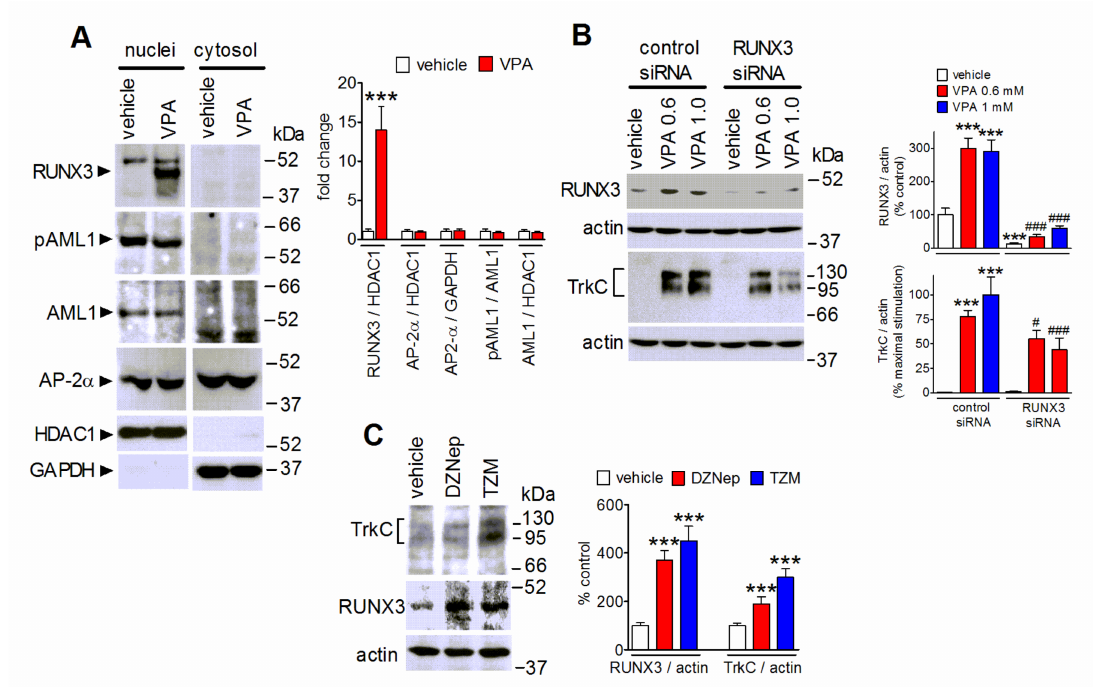
Figure 4. Involvement of RUNX3 in VPA-induced upregulation of TrkC. ( A ) SH-SY5Y cells were treated for 24 h with either vehicle or 1 mM VPA. Nuclear extracts and cytosolic fractions were prepared and analyzed for RUNX3, phospho-Ser249- AML1 (pAML1), AML1, AP-2 α , HDAC1 and GAPDH levels. Values are the mean ± SD of four independent experiments. *** p < 0.001 vs. control (vehicle) by Student’s t test. ( B ) SH-SY5Y cells transfected with either control siRNA or RUNX3 siRNA duplexes were incubated for 24 h with either vehicle, 0.6 mM VPA (VPA 0.6), or 1 mM VPA (VPA 1.0). Cell lysates were analyzed for RUNX3 and TrkC expression. Values are the mean ± SEM of four independent experiments. *** p < 0.001 vs. control (control siRNA + vehicle). # p < 0.05, ### p < 0.001 vs the corresponding value in control siRNA-treated cells. ( C ) SH-SY5Y cells were incubated for 72 h in growth medium with either vehicle, 1 µ M 3-deazaneplanocin A (DZNep), or 1 µ M tazemetostat (TZM). Cell lysates were analyzed for TrkC and RUNX3 levels. Values are the mean ± SD of four independent experiments. *** p < 0.001 vs. the corresponding control value (vehicle) by ANOVA followed by Tukey’s